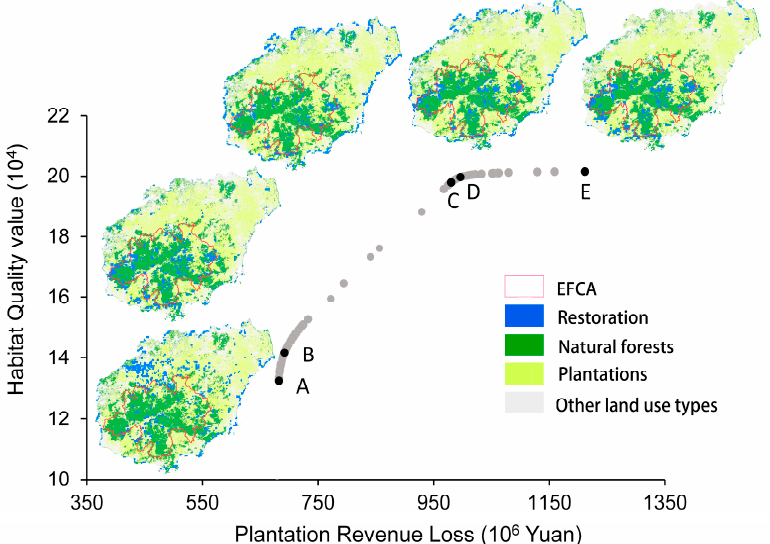
Figure 2. E ffi ciency frontier between plantation revenue loss and habitat quality. Present value of plantation revenue loss generated by forest restoration is shown on horizontal axis. Value of habitat quality is shown on vertical axis. The potential ES values from forest restoration were the di ff erences in ES values between restored and baseline patterns (i.e., LULC pattern in 2017). E ffi ciency frontier is outlined by gray circles. Dark points on frontier associated with letter have corresponding land-use patterns. A = minimum plantation revenue loss, B = 25% of maximum habitat quality value, C = 50% of maximum habitat quality value, D = 75% of maximum habitat quality value, and E = maximum value of habitat quality.